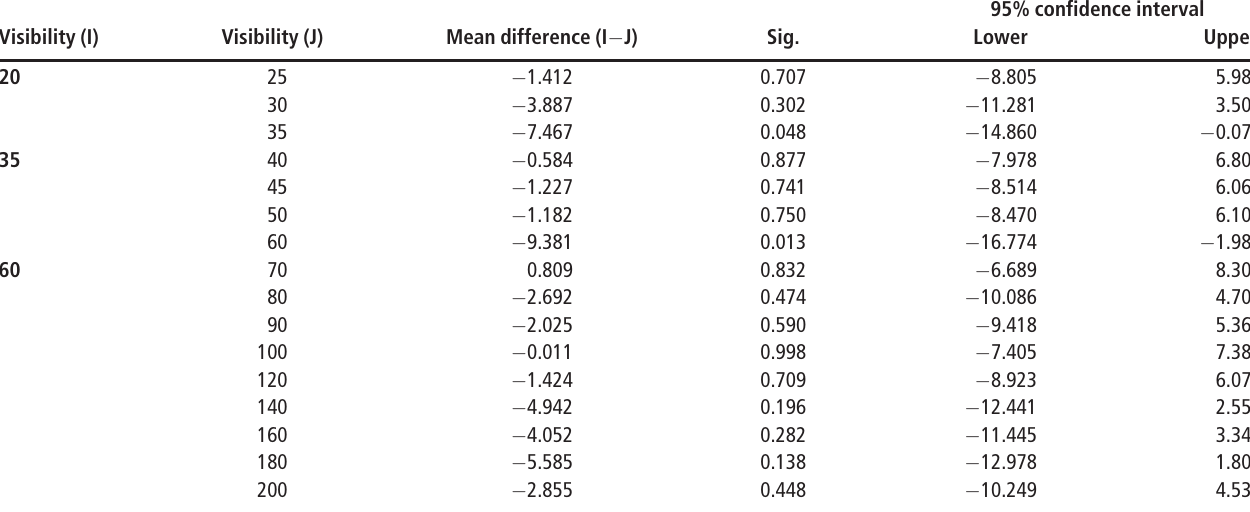
Table V Multiple comparisons of the effect of visibility conditions on average speed at curved segment Visibility (I) Visibility